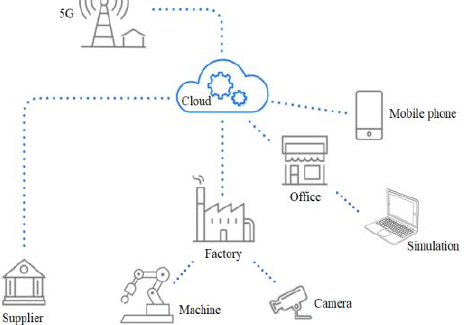
Fig.5. Operation process of cloud